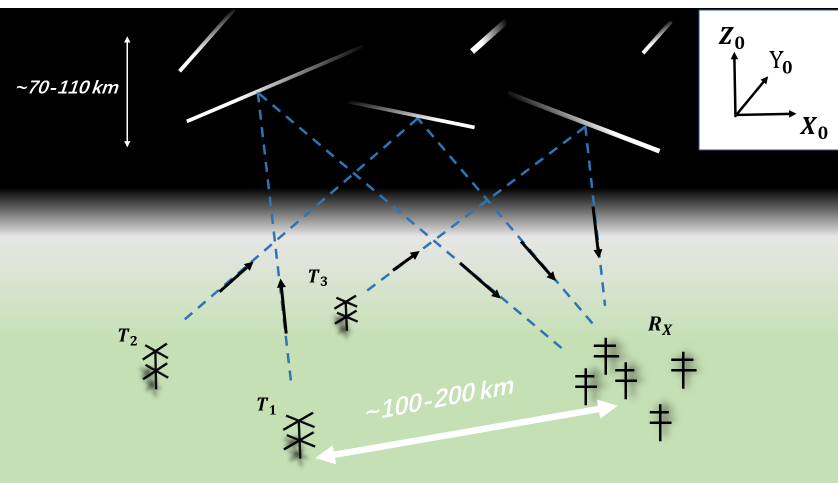
Figure 2. Schematic diagram of a multistatic meteor radar system using SIMO (single-input and multi-output). There are three transmitters ( T 1 , T 2 and T 3 ) and one receiver ( R X ) in the picture. The transmitter–receiver distance is typically 100–200km. X 0 , Y 0 and Z 0 represent the east, north and up directions of the receiving antenna. Over 90% of the received energy comes from about 1km around the specular point of the meteor trail, which is slightly less than the length of the central Fresnel zone (Ceplecha et al.,